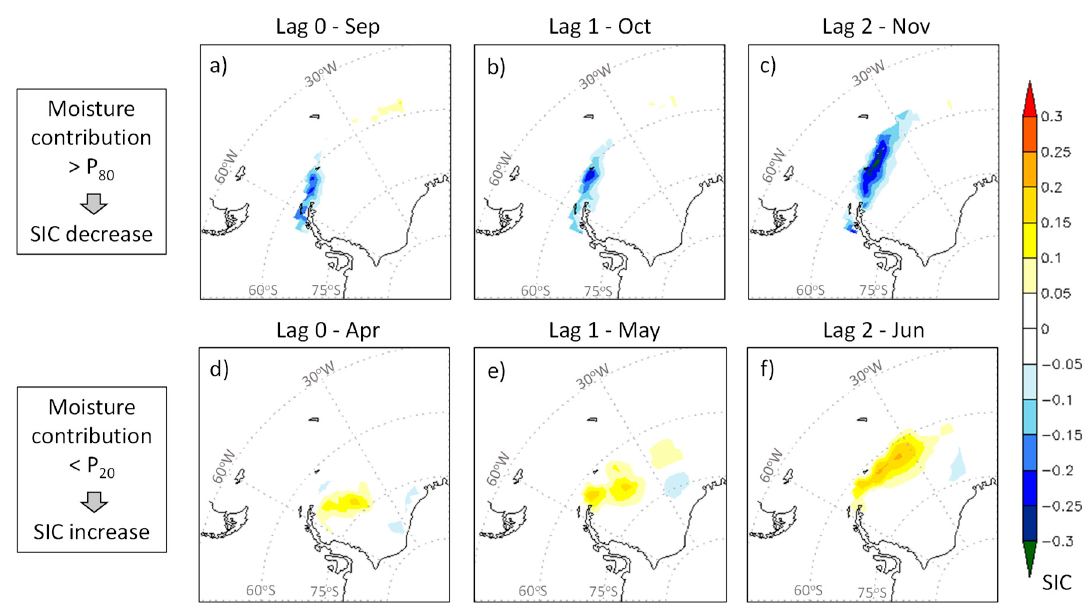
Figure 10. Composite anomalies of SIC for high (P80, top) and low (P20, bottom) monthly extremes of the moisture sink (vide text to more details) over the Weddel Sea for the lags-0 (0 month lag) ( a , d ), lag-1 (1 month lag) ( b , e ) and lag-2 (2 months lag) ( c , f ) months. Top panel uses the moisture sink from September and the SIC from September, October, and November for, respectively, lag-0, lag-1, and lag-2. Bottom panel uses the moisture sink from April and the SIC from April, May and June for, respectively, lag-0, lag-1, and lag-2.